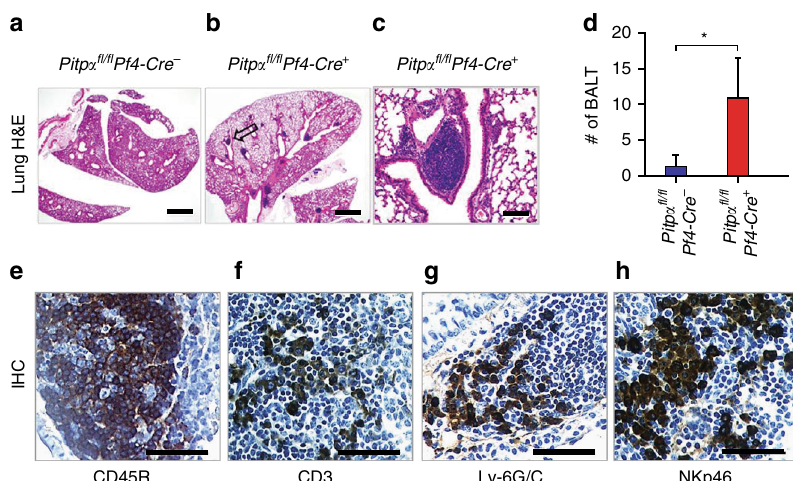
Fig. 5 Loss of PITP α in platelets leads to a mucosal immune response. a – c Lung tissues were harvested 48 h after tumor injection and stained with H&E. Pitp α fl / fl Pf4-Cre + mice lacking PITP α in their platelets ( b ) demonstrate prominent formation of BALT (bronchus-associated lymphoid tissue or BALT hyperplasia), such as the one indicated by the arrow. This response was rarely observed in the control mice ( a ). A higher magni fi cation of a typical BALT hyperplasia is shown in c . The black scale bars indicate 200 μ m for a , b , and 50 μ m for c . d Average number of BALT hyperplasia per section across 300 μ m ( n = 3 mice per group, * p < 0.05, unpaired Student ’ s t -test. Error bars are s.d.). e – h Immunohistochemistry staining of hyperplasia in Pitp α fl / fl Pf4-Cre + mice for major leukocyte makers as indicated. Black scale bars represent 200 µ